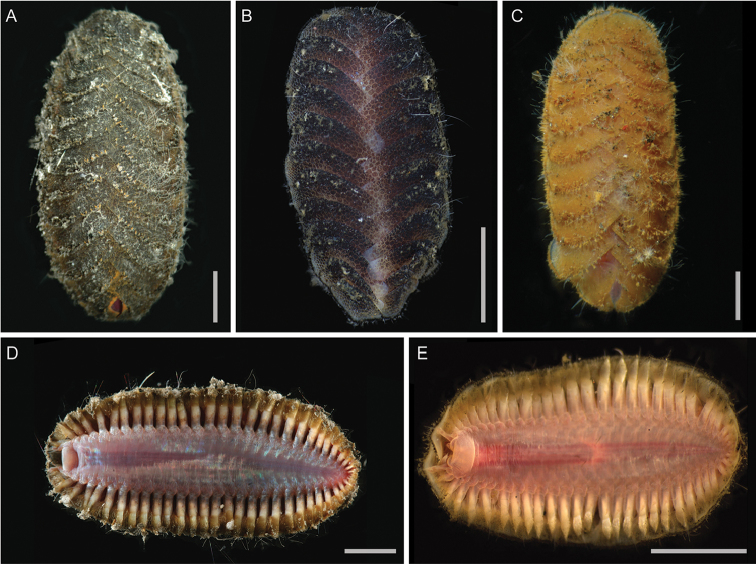
Dorsal and ventral micrographs of species in Thermiphione. Scale bars represent 5 mm. AThermiphionefijiensis (SIO-BIC A7975), dorsal BThermiphionerisensis (SIO-BIC A6326, was Iphionellarisensis), dorsal CThermiphionetufari (SIO-BIC A7973), dorsal DThermiphionefijiensis (SIO-BIC A7975), ventral EThermiphionerisensis (SIO-BIC A6326), ventral.